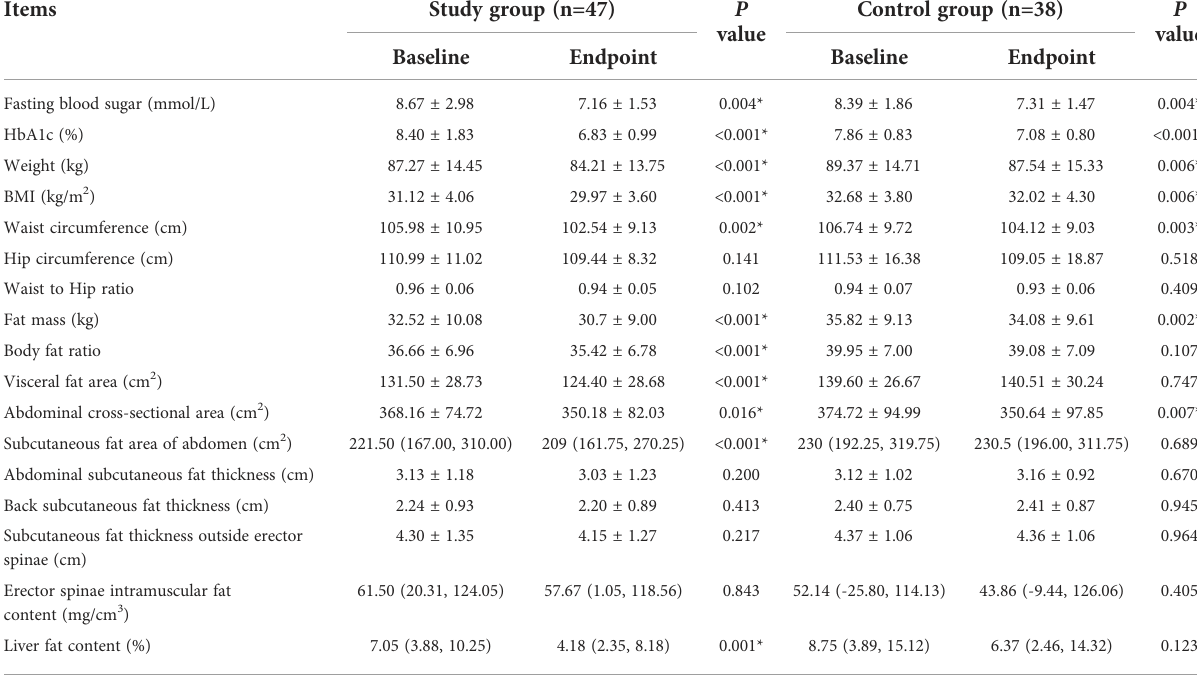
TABLE 2 Changes of blood sugar related indicators, physical measurements, and abdominal fat distribution.